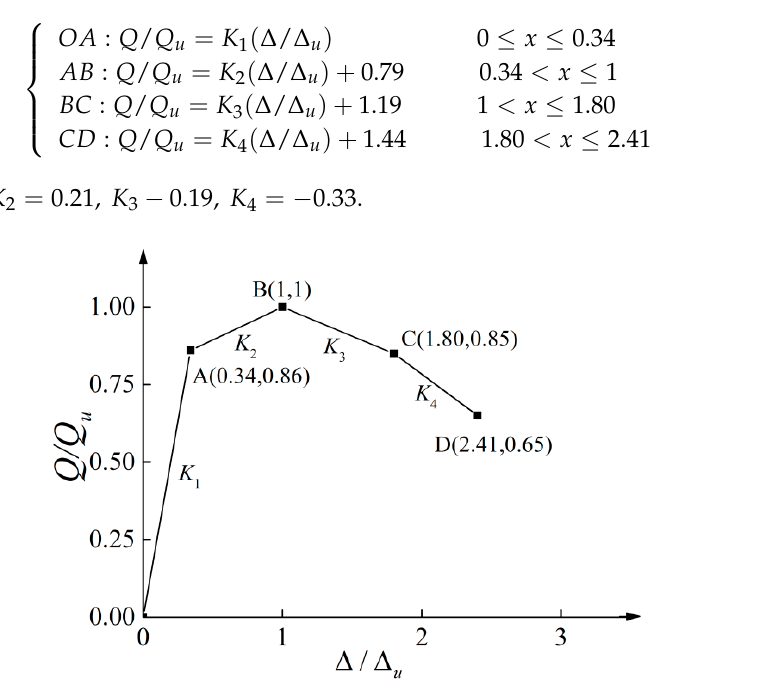
Figure 11. The generalized four-line envelope curve of the PRMSW.